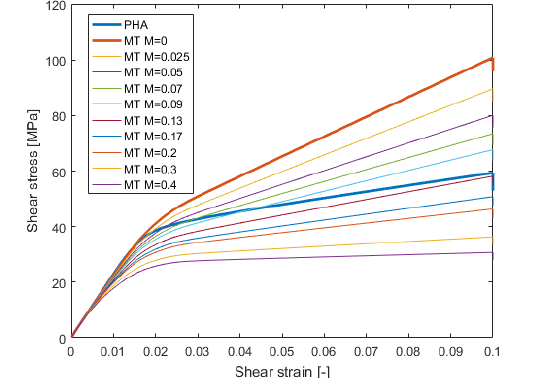
Figure 10. Comparison of FEM and MT predictions with ω given by Eq.